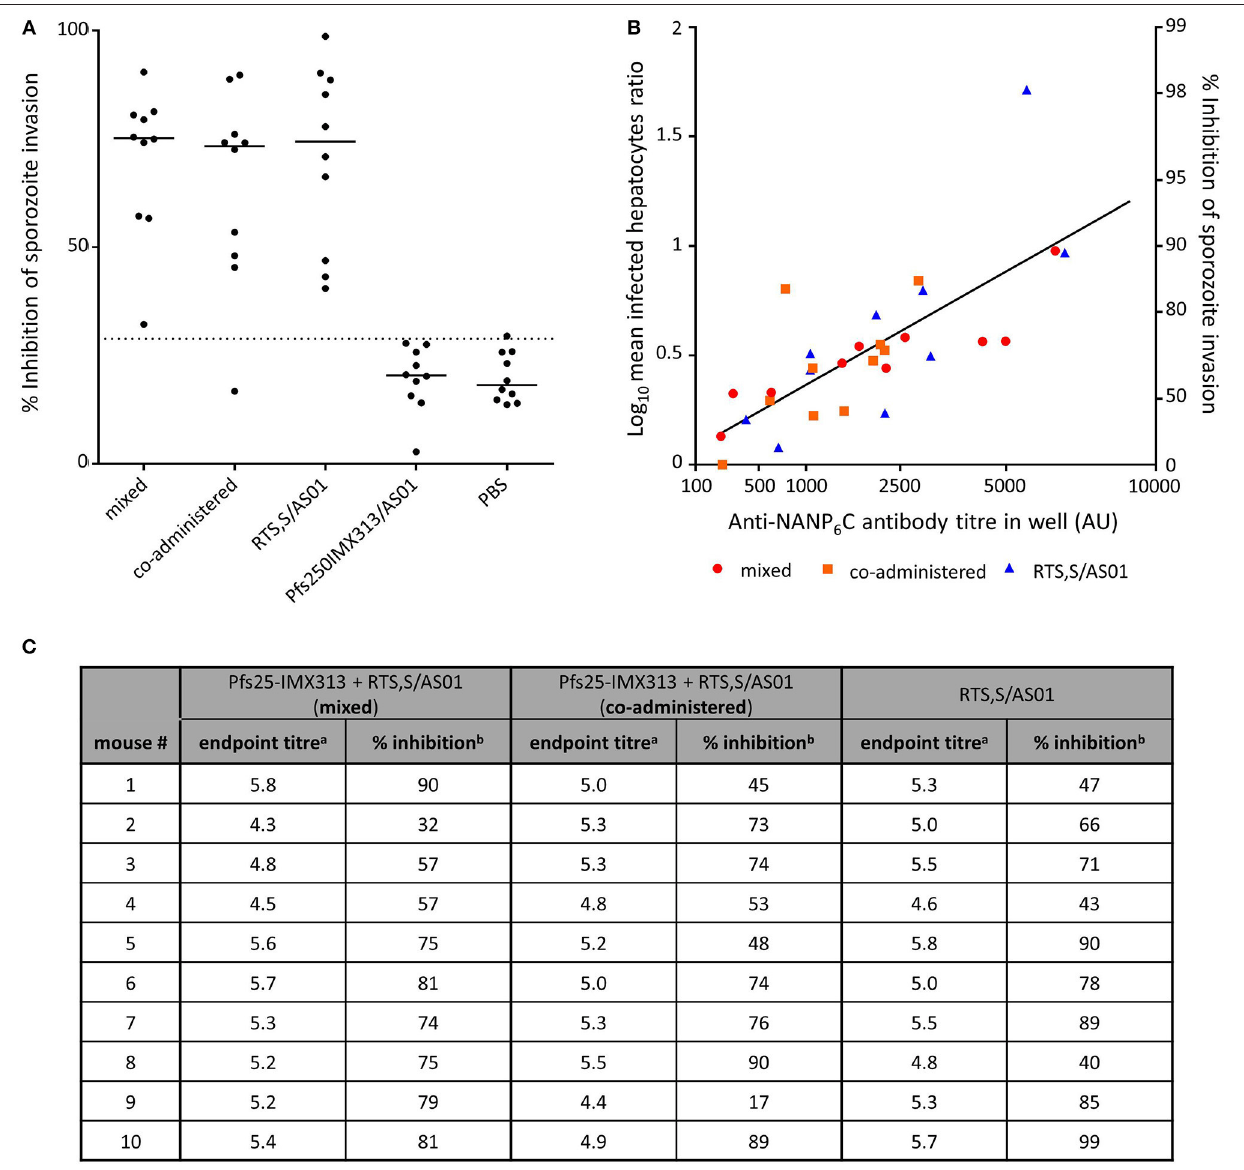
at 37 ◦ C and then transferred into cluster tubes. The empty